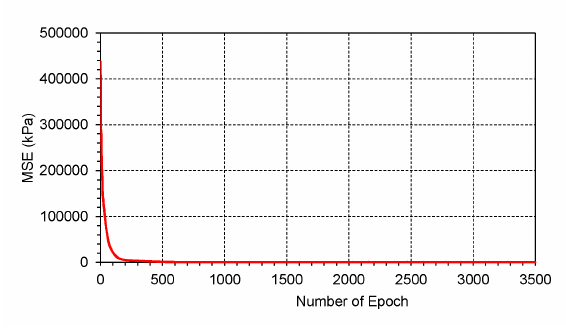
Fig. 8. The curve of MSE criteria by training epoch